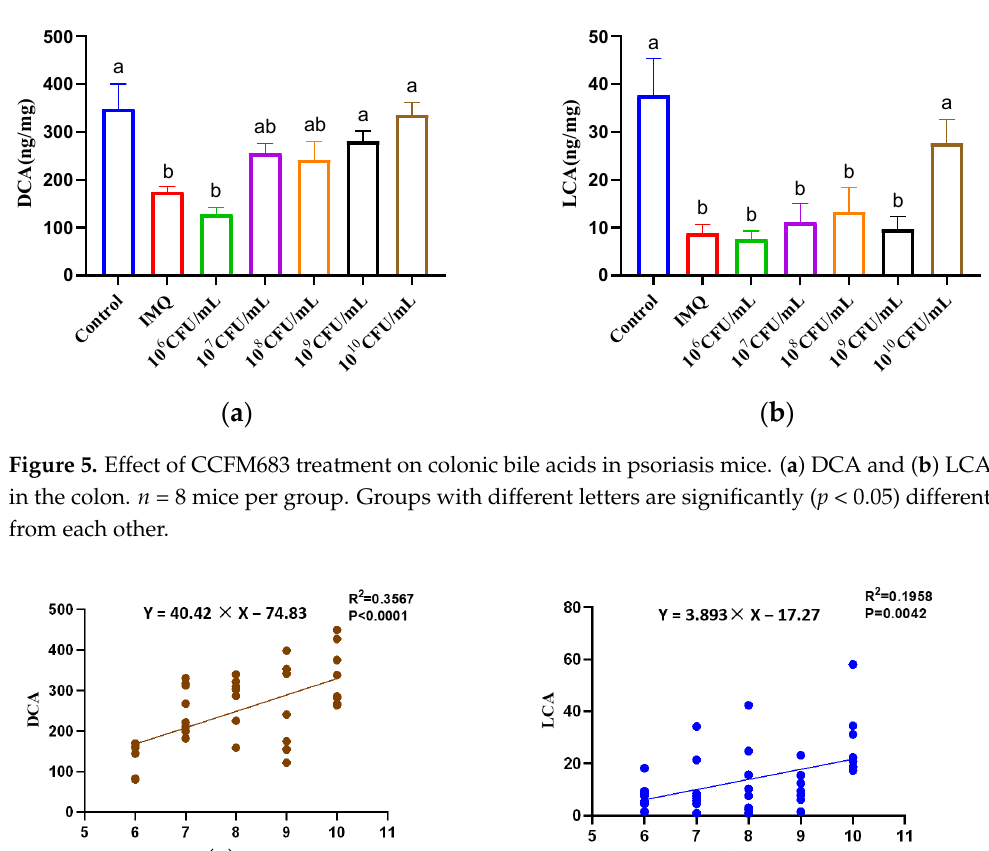
Figure 5. Effect of CCFM683 treatment on colonic bile acids in psoriasis mice. ( a ) DCA and ( b ) LCA in the colon. n = 8 mice per group. Groups with different letters are significantly ( p < 0.05) different from each other.